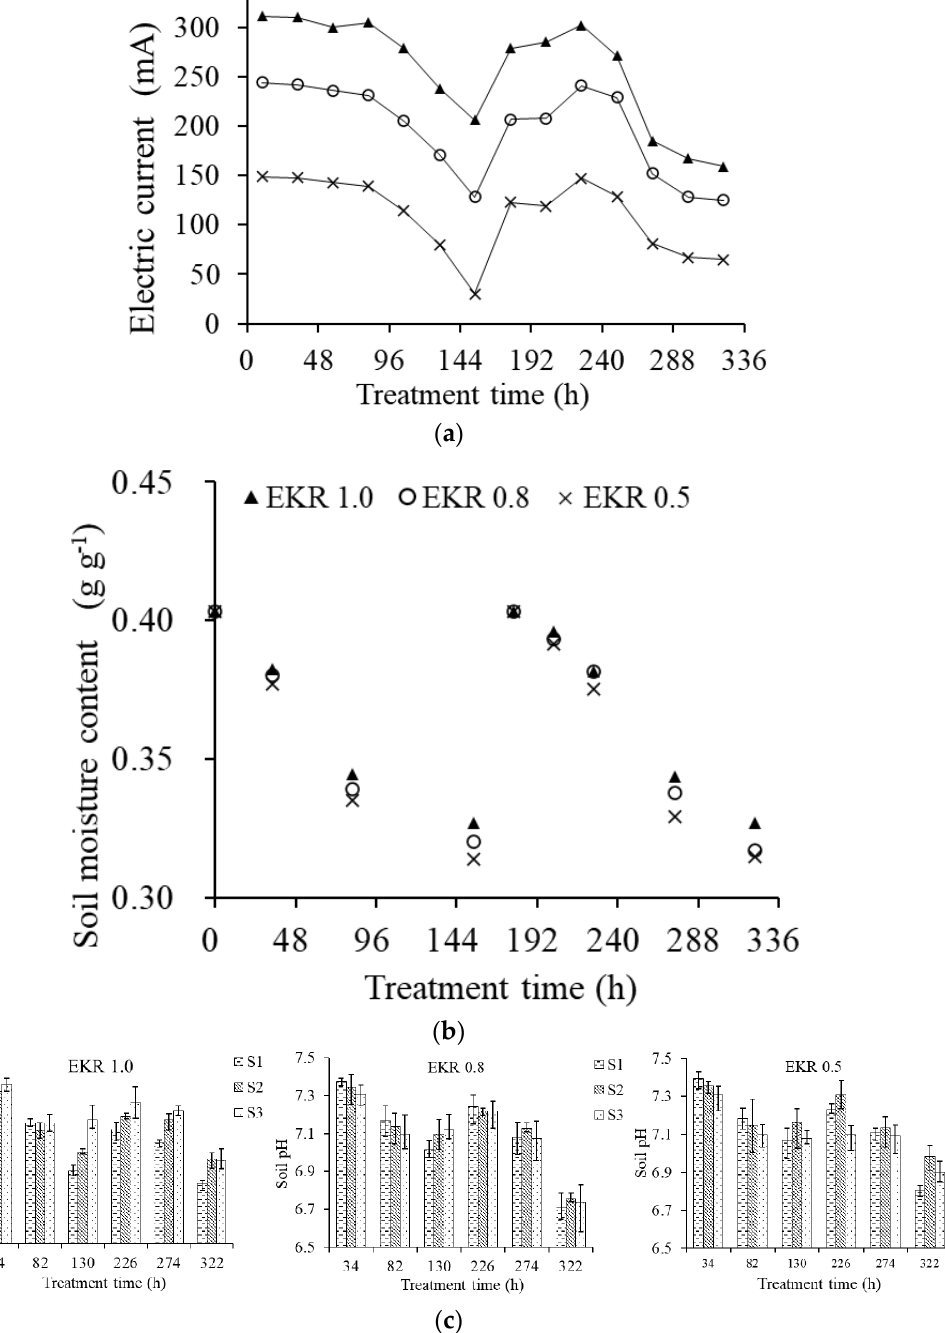
Figure 2. Electric current ( a ), soil moisture content variation ( b ), and soil pH in different soil sections ( c ) during the electrokinetic remediation process.